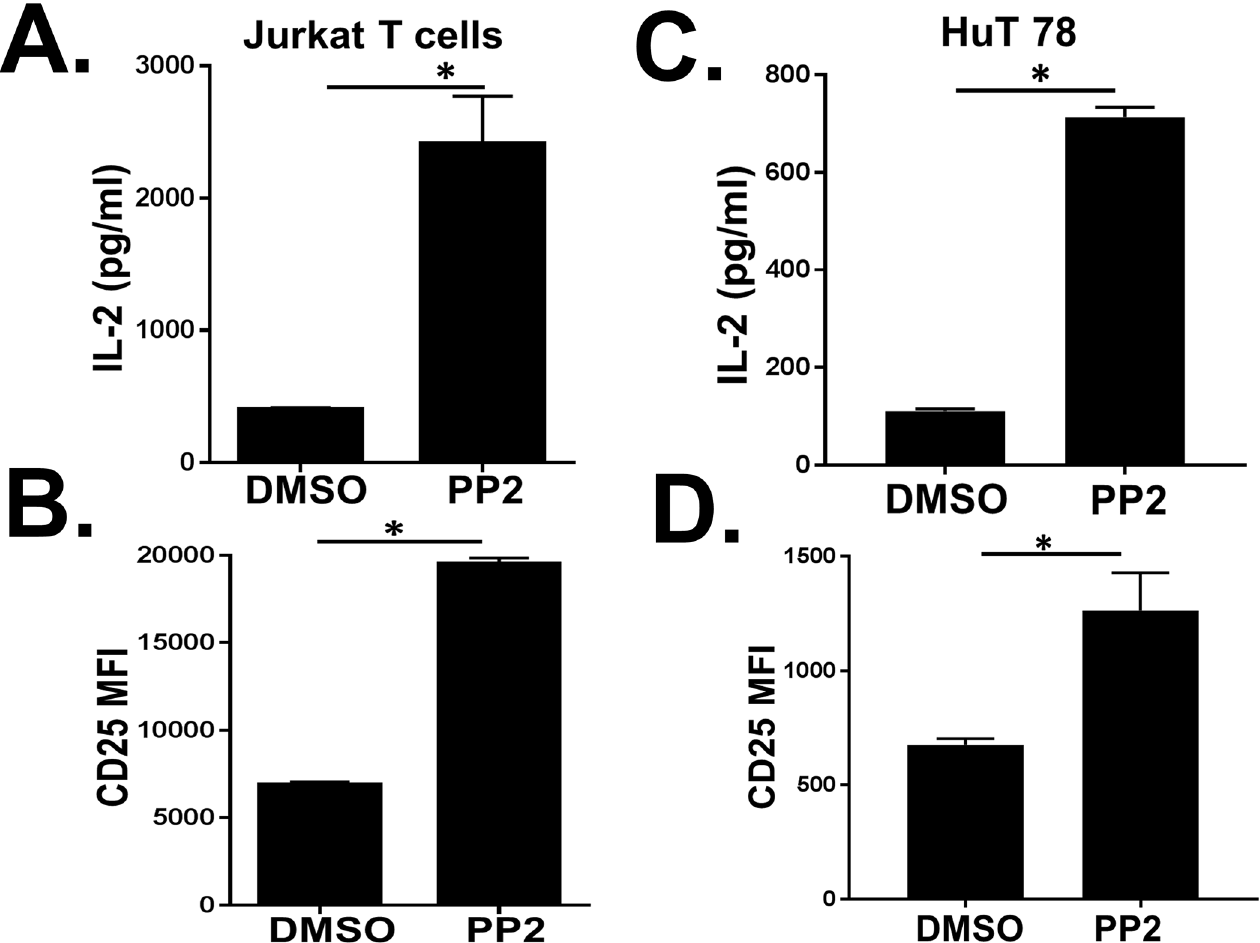
Fig 2. Inhibition of Src-family kinases (SFKs) enhances distal T cell receptor (TCR) signaling in two different human T cell lines. Activation of distal TCR signalingwas measuredin two different humanT cell lines by assessing(A, C) IL-2 release and (B, D) CD25surface expressionfollowingDMSO or PP2 (5 μ g/ml)treatment and PMA/Ionomycin stimulation. Jurkat cells = panels A and B. HuT78 = panels C and D. Data represent the averageof three technicalreplicates, and the standard deviationis shown. Each experiment was independently performed three times with similar results. * P <